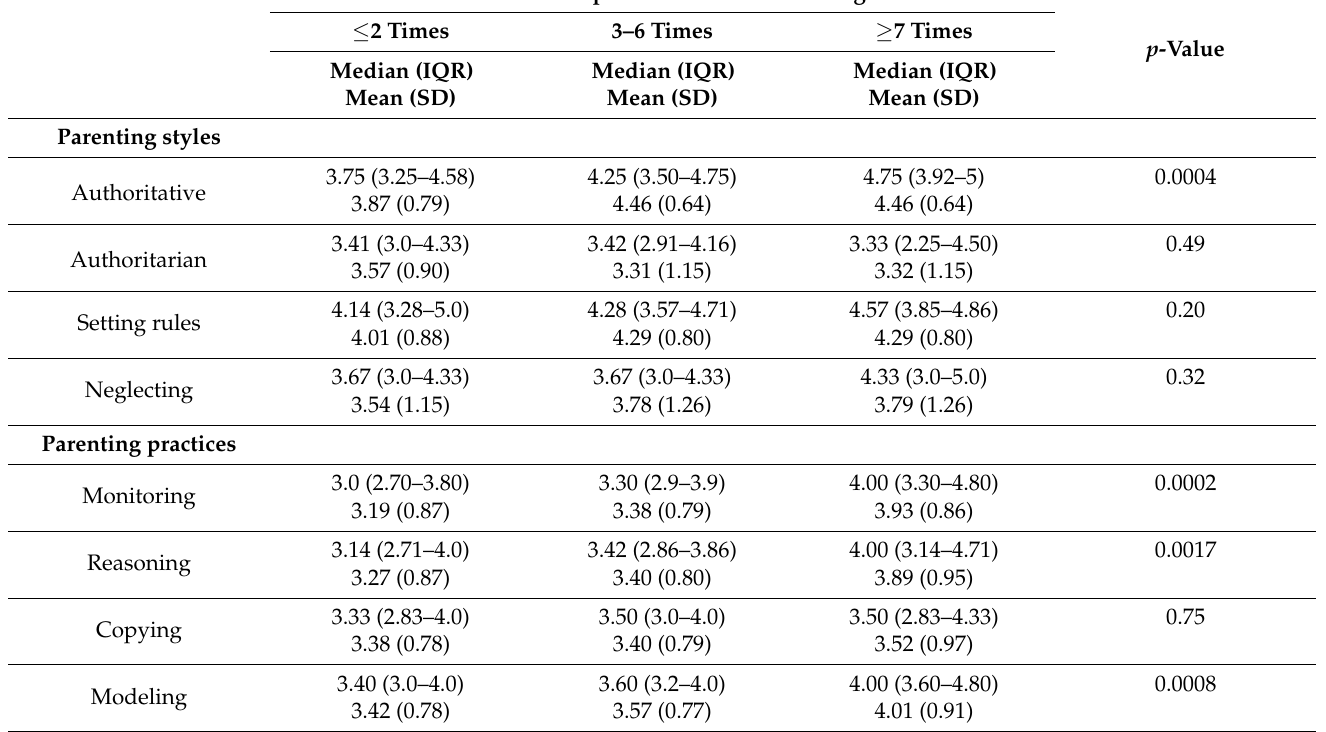
Table 8. Relationship between weight status and parenting styles, food parenting practices, and family meal